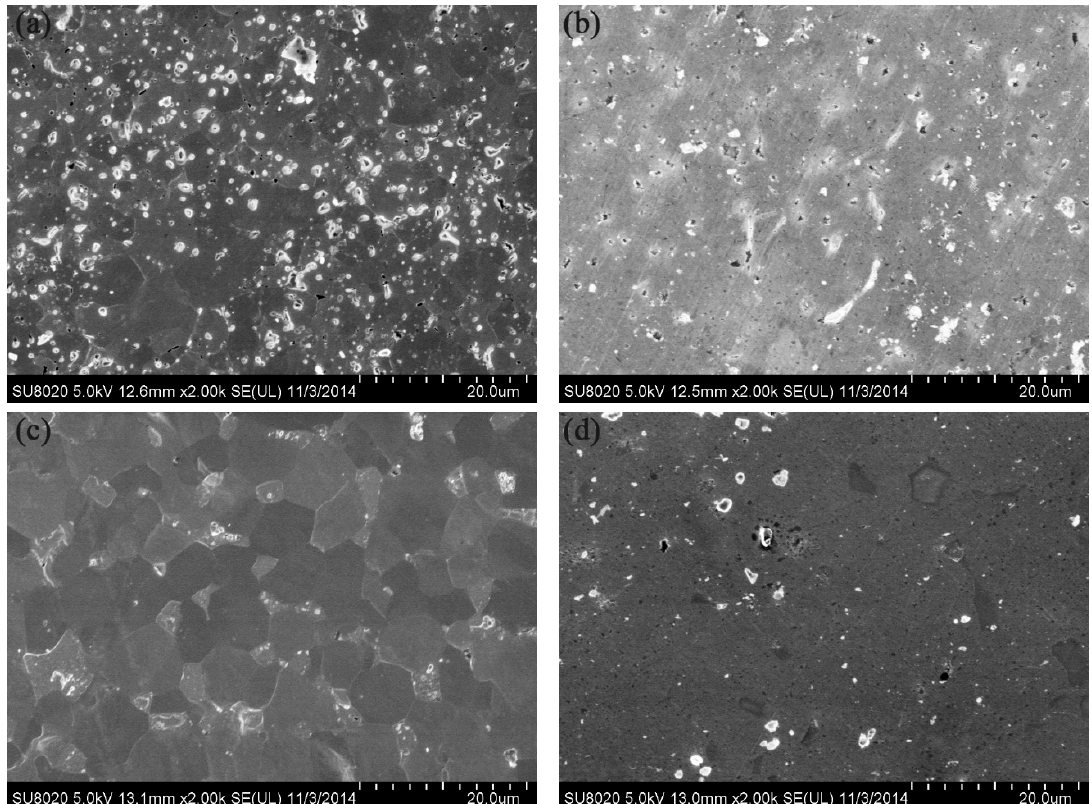
Figure 10. SEM images of samples exposed to 50 eV He-ions to the fluence of 1 × 10 22 m − 2 for 1 h. ( a ) Irradiated area of W–1 wt % Nd 2 O 3 ; ( b ) Unirradiated area of W–1 wt % Nd 2 O 3 ; ( c ) Irradiated area of